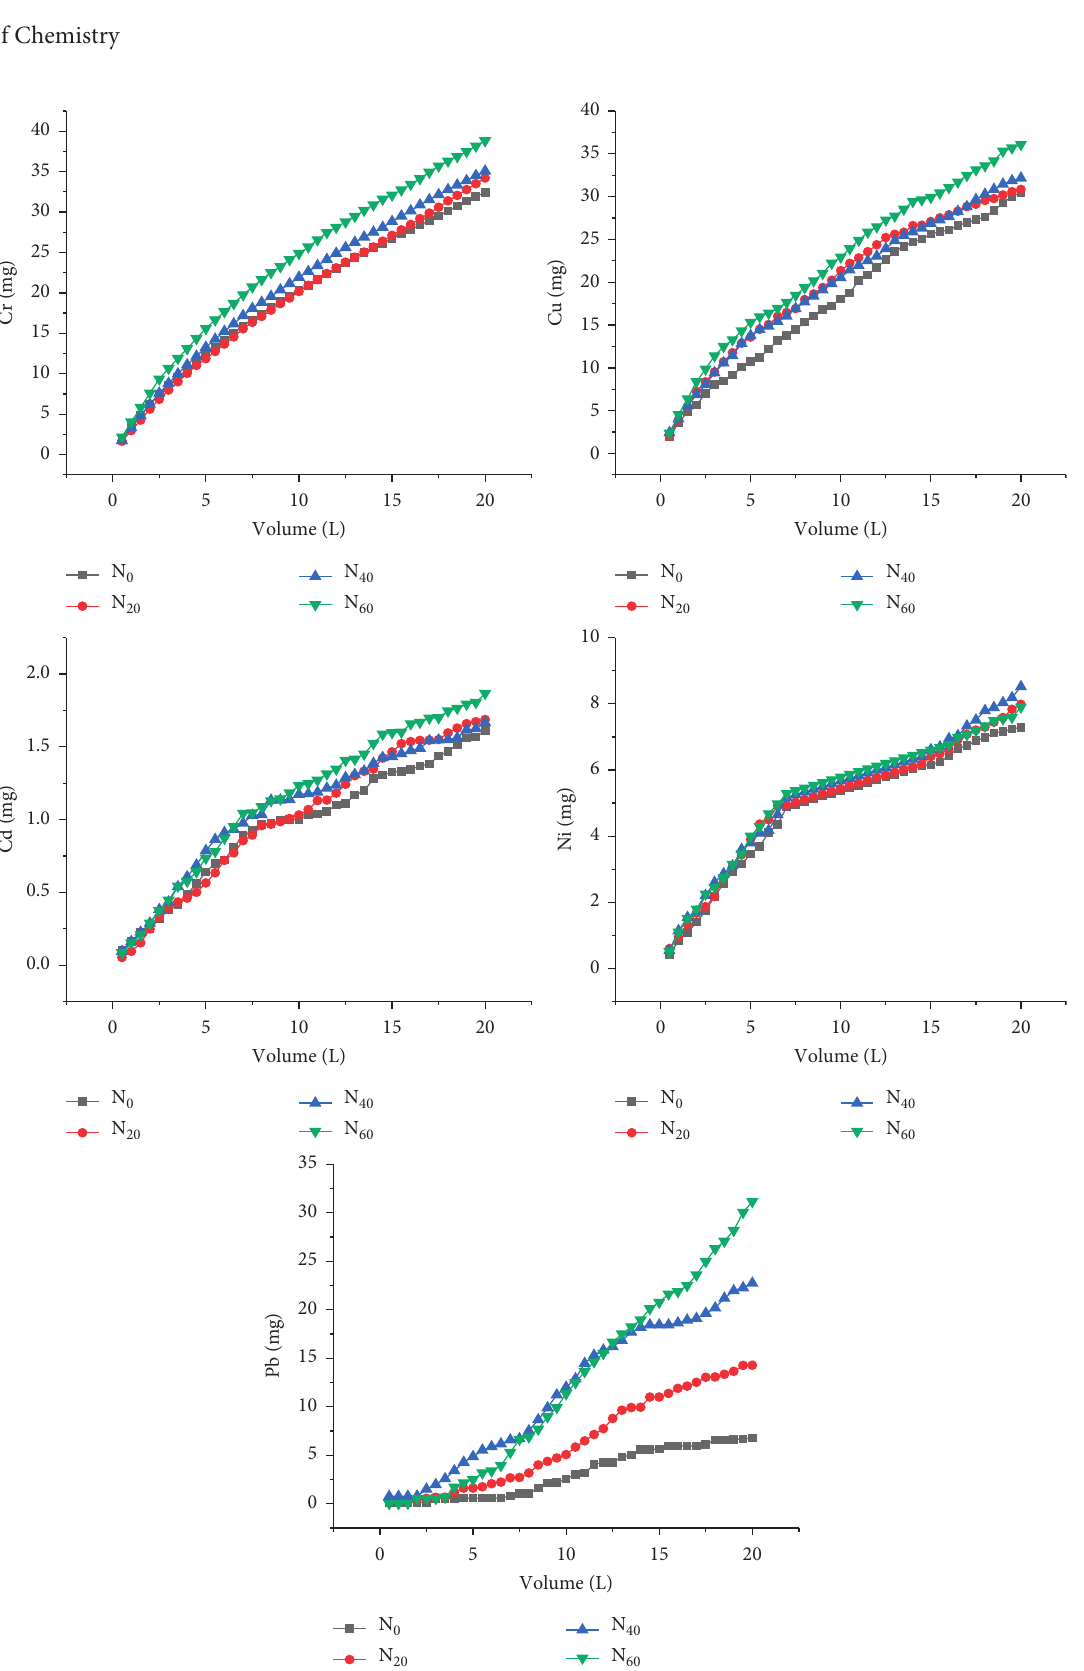
Figure 3: Cumulative release amounts of HMs in the soil of the WFLZ in the TGR